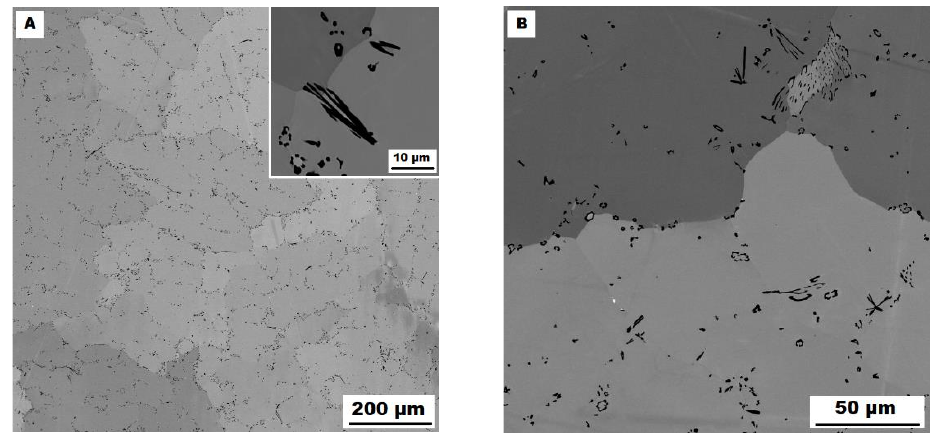
Figure 8. The structure of Fe – 28Al – 5Si – 2Ti – 1B alloy in the as-cast state (SEM, 10 kV, BSE). ( A ) overview of the structure, ( B ) detail of the structure.